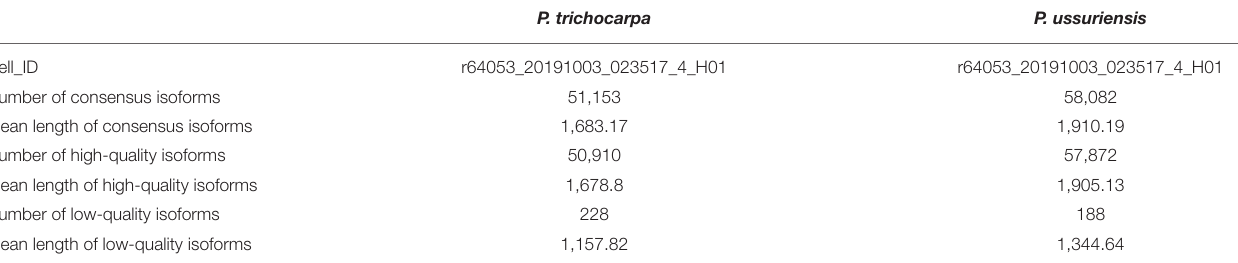
TABLE 1 | Difference in genes as annotated in two poplar species compared with P. trichocarpa genome by the PacBio sequencing data, respectively.